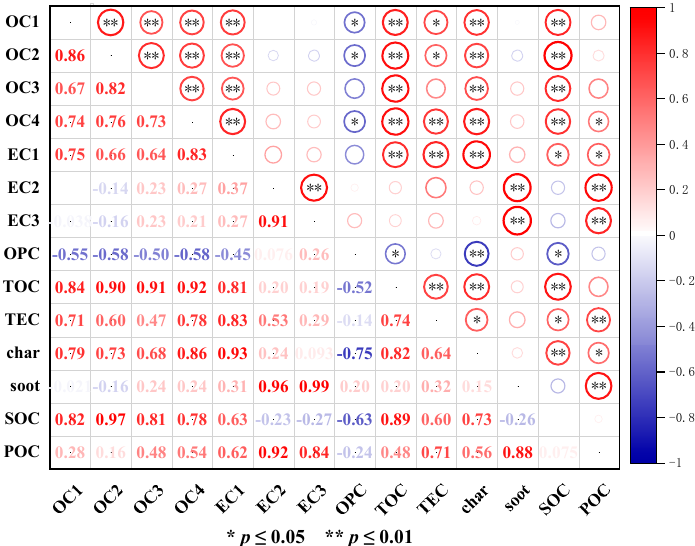
Figure 5. Correlation heat map between different carbon components.